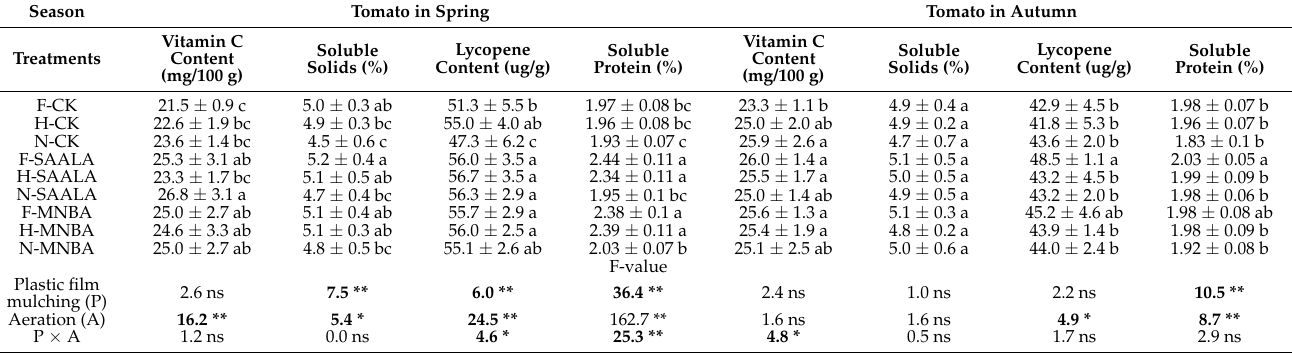
Table 5. Effects of different aeration treatments on nutritional indices of